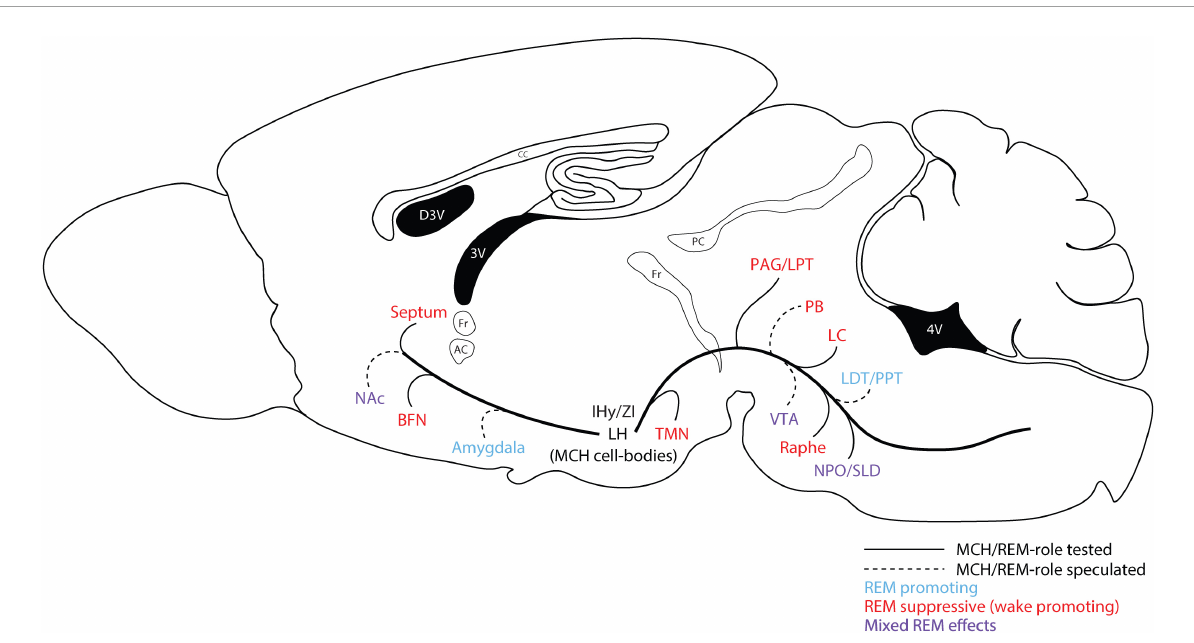
FIGURE2 Putative brain regions participating in the REM sleep-promoting effects of the MCH system. Various REM-promoting and REM-suppressing neuronal populations/brain regions receive innervation from the MCH system. Studies have demonstrated REM-promoting effects of the MCH system through local actions in many of these regions. Generally, MCH is thought to directly inhibit REM-suppressing neurons through MCHR1/Gi/o. Multiple microinjection and optogenetic studies have demonstrated REM-promoting effects of MCH in regions such as the raphe, LC, TMN, and BFN (see Figure 1 for references). MCH may also directly or indirectly modulate activity within REM-promoting regions such as the SLD/NPO, though the evidence for this is less clear. Other brain regions are likely implicated in the regulation of specific aspects of REM sleep phenomena, or related phenomena such as cataplexy—though they are not sufficient for the generation of REM sleep—and these may also be modulated by MCH. For example, MCH projections to the VTA, the nucleus accumbens (NAc), and/or the amygdala, may modulate dopamine (DA) release (Mul et al., 2011, Domingos et al., 2013), which is likely to have downstream effects on wakefulness/sleep (Qu et al., 2008, 2010; Oishi et al., 2017), and also could have a role in cataplexy (Hasegawa et al., 2017,